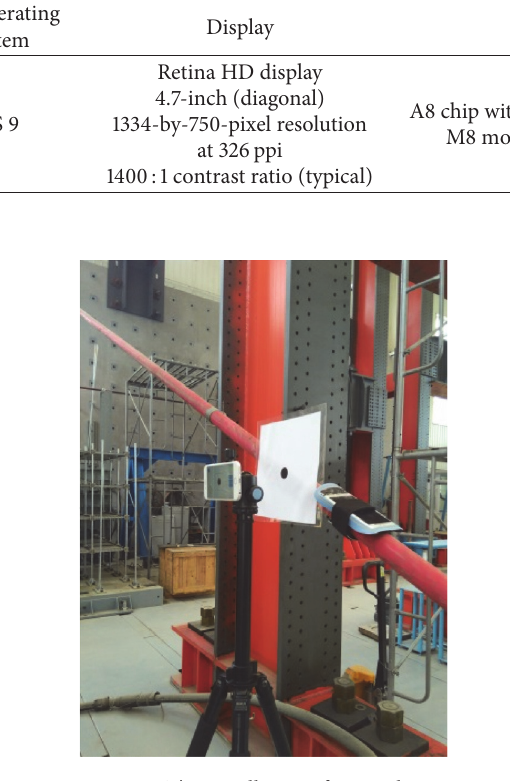
Figure 6: The installation of smartphones.